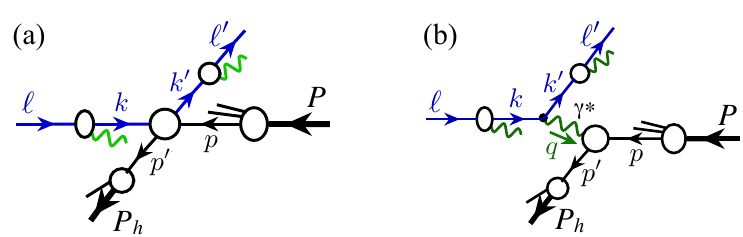
Figure 12 . Sketch of (a) the SIDIS process e ( ‘ ) + N ( P ) → e ( ‘ 0 ) + h ( P h ) + X , and (b) SIDIS in the one-photon exchange